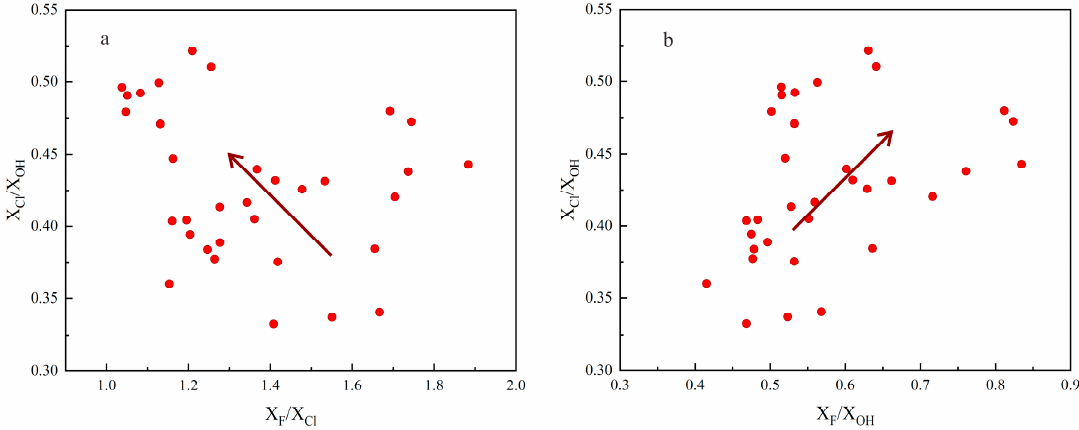
Figure 7. Plots of ( a ) X Cl /X OH versus X F /X Cl in apatites of dacite; ( b ) X Cl /X OH versus X F /X OH in apatites of dacite. The arrow shows the trajectory of apatite compositional